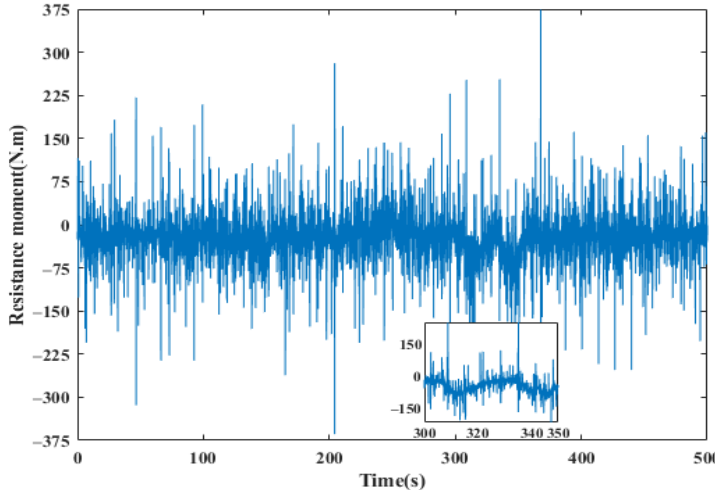
Figure 16. Resistance torque detection values when driving on flat terrain.